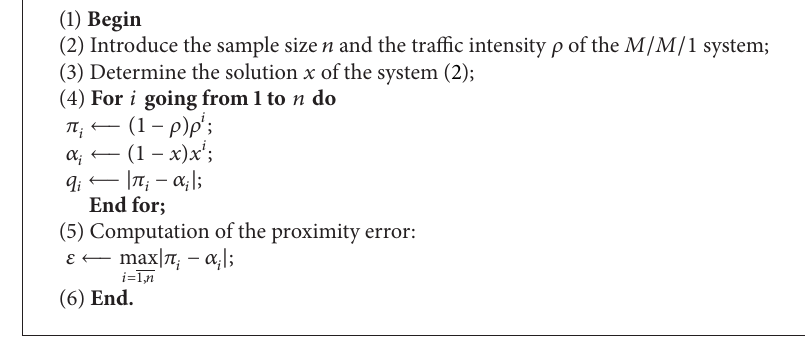
Algorithm 1: Approximation error with L 1 norm.